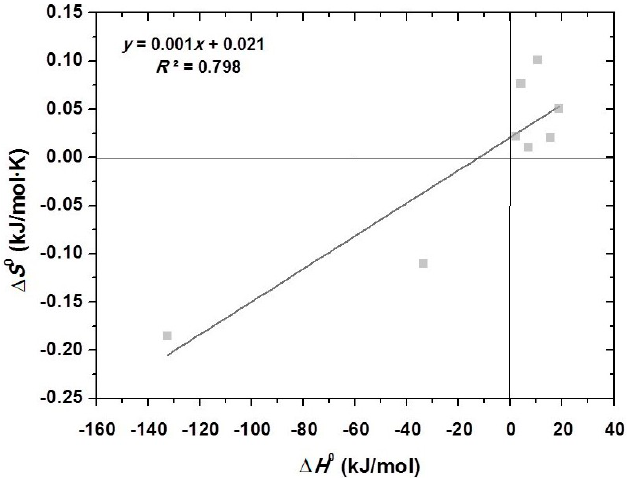
Figure 3. The enthalpy-entropy compensation plot for the works studied in the present review article (eight experimental points included).